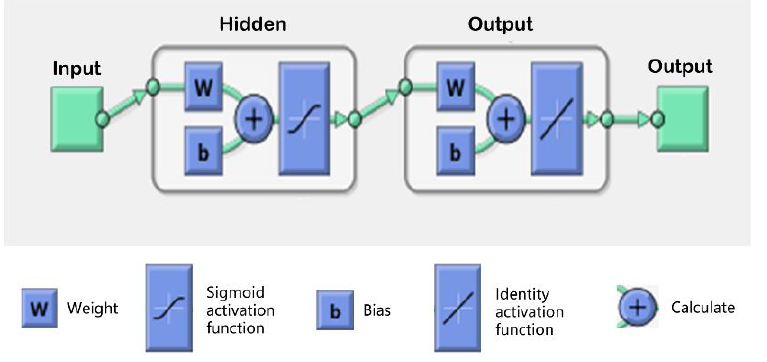
Figure 14. Neural network structure.